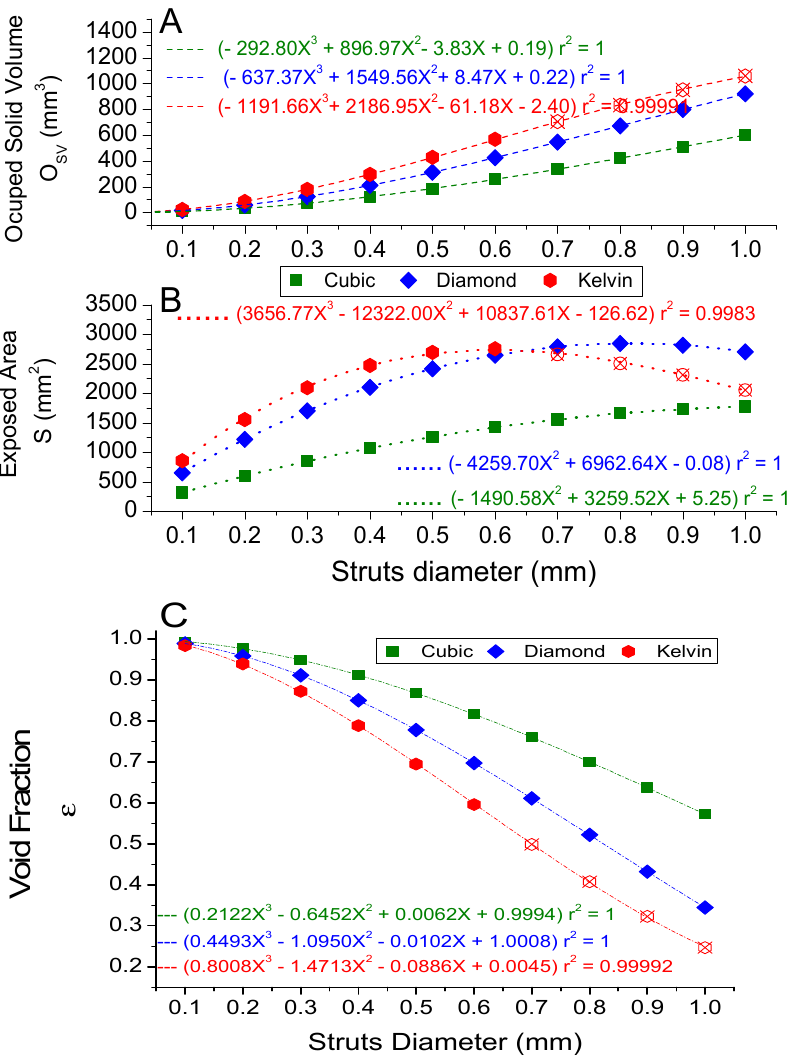
Figure 2. Structural parameters of the designed POCS: ( A ) Occupied Solid Volume (O SV ) vs. strut diameter; ( B ) Exposed Area (S) vs. strut diameter vs; ( C ) Void Fraction ( ε ) vs. strut diameter. (The empty symbols marked with X represent the CADs in which blockages of certain cavities are observed.)